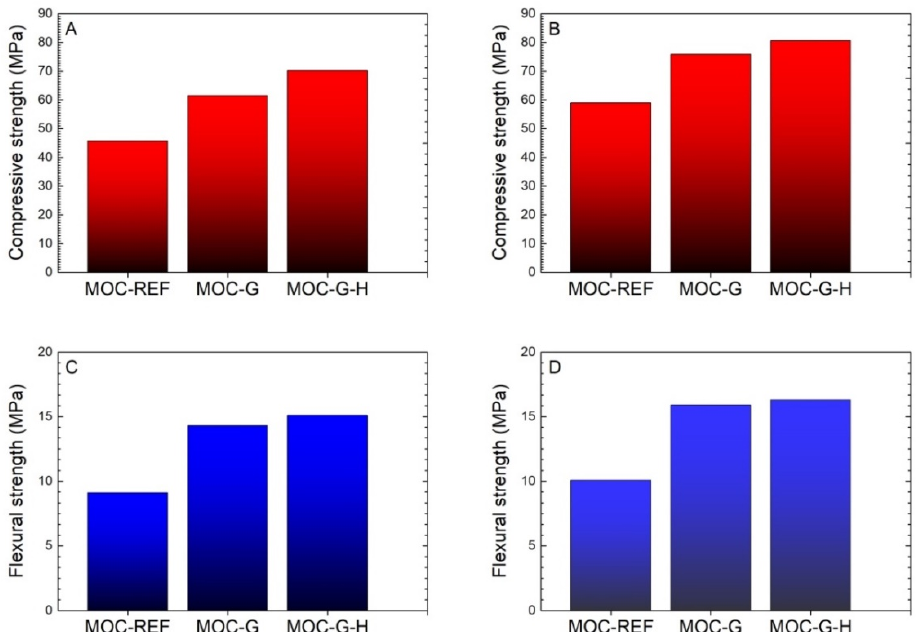
Figure 11. Mechanical parameters: ( A ) compressive strength of 7-day samples; ( B ) compressive strength of 28-day samples; ( C ) flexural strength of 7-day samples; ( D ) flexural strength of 28-day samples.